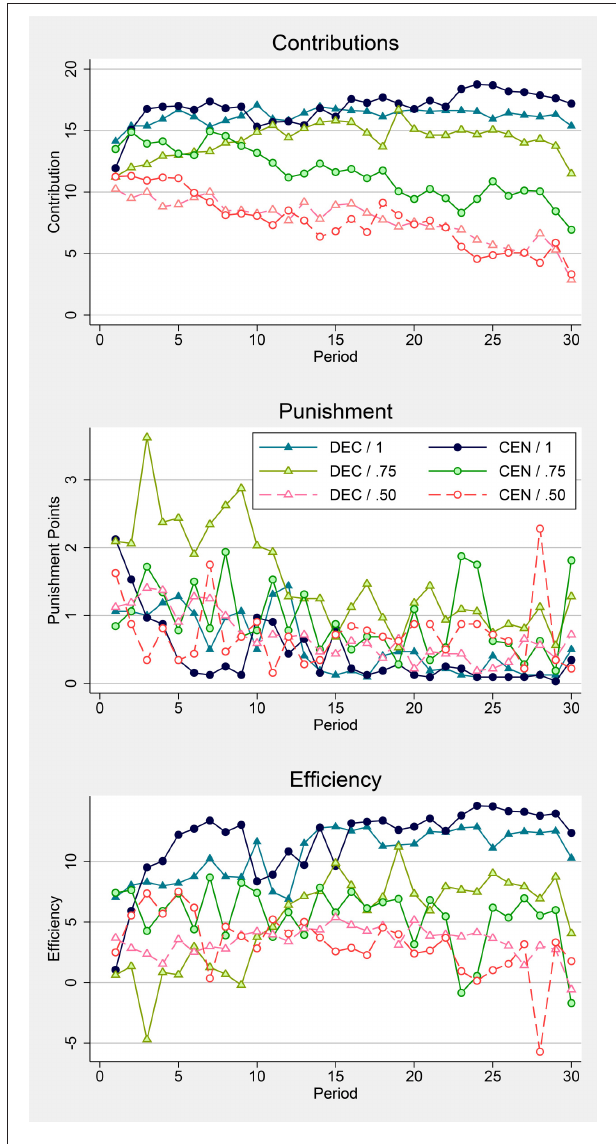
FIGURE 1 | Outcomes. Treatments with DECentralized or CENtralized punishment and a probability of a correct signal about individual contributions of 1, 0.75, or